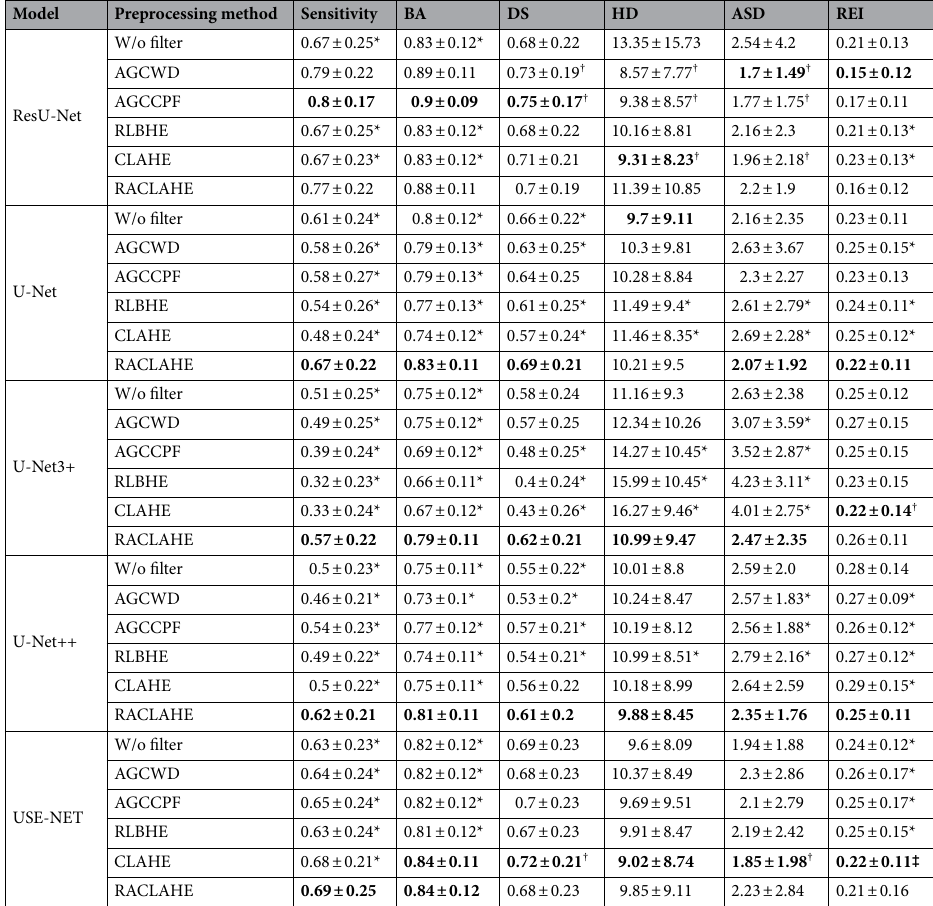
Table 2. Peripheral zone (PZ) segmentation performance. BA balanced accuracy, DS dice score, HD Hausdorff distance, ASD average surface distance, REI Rand error index, AGCWD adaptive gamma correction with weighting distribution, AGCCPF adaptive gamma correction with color preserving framework, RLBHE range limited Bi-histogram equalization, CLAHE contrast limited adaptive histogram equalization, RACLAHE region adaptive contrast limited adaptive histogram equalization. *RACLAHE performs significantly better than the corresponding method (p-value ≤ 0.05; Wilcoxon rank-sum test). † This method is significantly better than RACLAHE (p-value ≤ 0.05; Wilcoxon rank-sum test). The best performance scores for each model are shown in